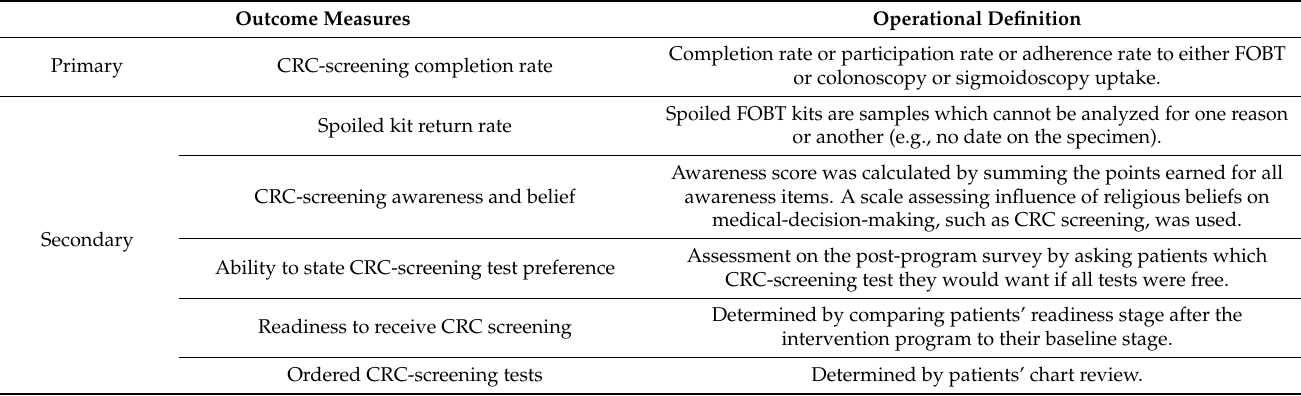
Table 1. Outcome measures and operational definitions